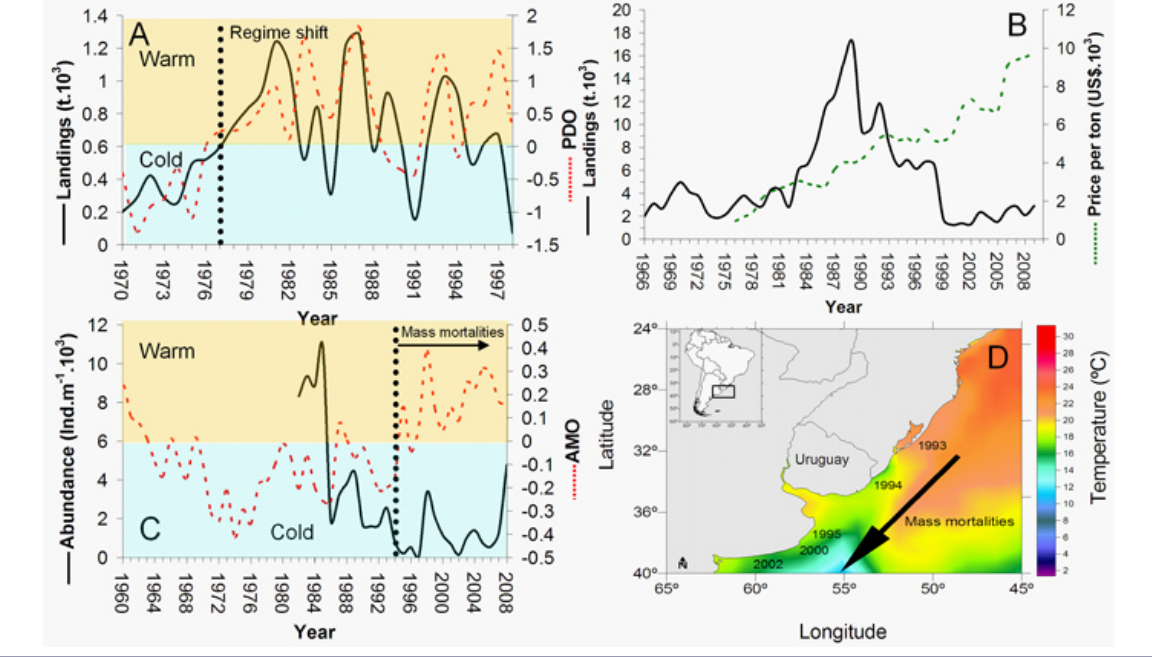
Fig. 1 . (A) Long-term variations in the surf clam ( Mesodesma donacium ) landings and Pacific Decadal Oscillation (PDO) index for northern Chile. The shaded bar indicates a climate shift that occurred in 1977, according to Fiedler (2002) and Chavez et al. (2003). See the drastic decline in landings and PDO during the 1997/1998 El Niño. (B) Long-term trends in landings and unit prices for the surf clam fishery in Chile. (C) Long-term trends in abundance of the yellow clam ( Mesodesma mactroides ) in a Uruguayan beach and Atlantic Multidecadal Oscillation (AMO) index. See the match in the regime shift from a cold to a warm period that took place between 1994 and 1995 (Goldenberg et al. 2001) and the occurrence of mass mortalities. (D) At a large scale, these mortalities sequentially occurred in a north-south direction from 1993 (southern Brazil) to 2002 (Argentina). For illustration purposes, sea surface temperature for the year 2006 is shown. Data source: Ortega et al.